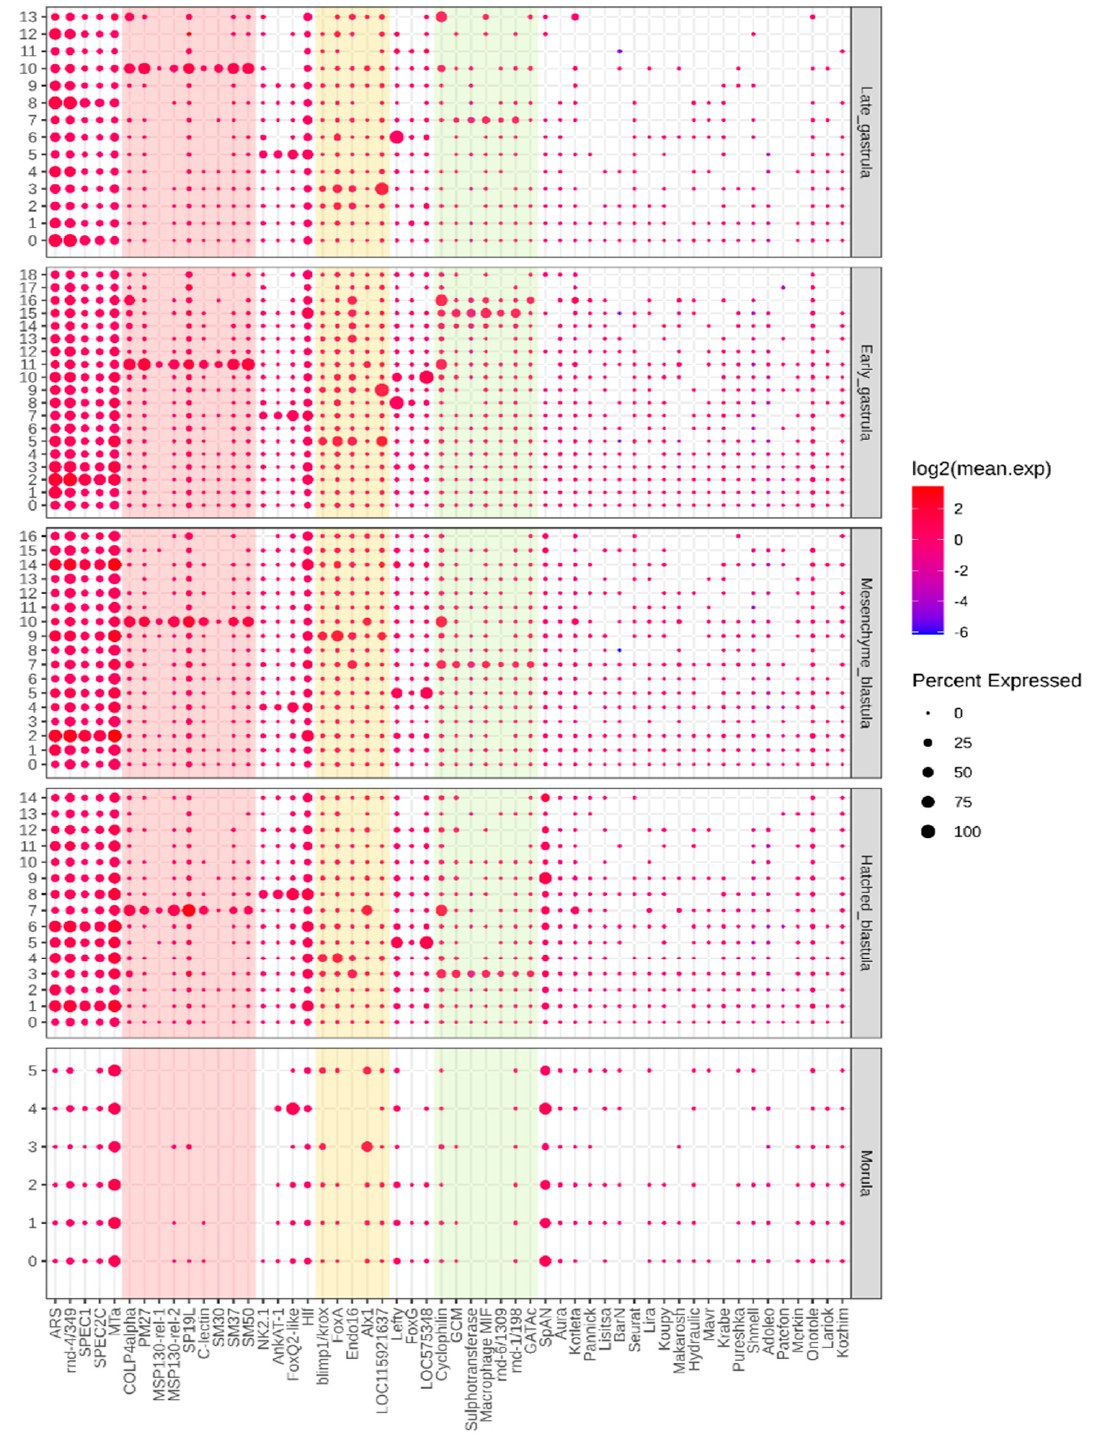
Figure 6. Results of the single-cell RNA-seq analysis. Dot plot of the expression of cell populations markers and REs. From left to right: ARS to MTa—aboral ectoderm markers; COLP4alpha to SM50 —PMC markers (marked in pink); NK2.1 to Hlf —apical plate markers; blimp1 / krox to LOC115921637 —endoderm markers; Lefty to LOC575348 —oral ectoderm markers; Cyclophilin to GATAc —markers of SMC; Aura to Kozhim —novel REs.